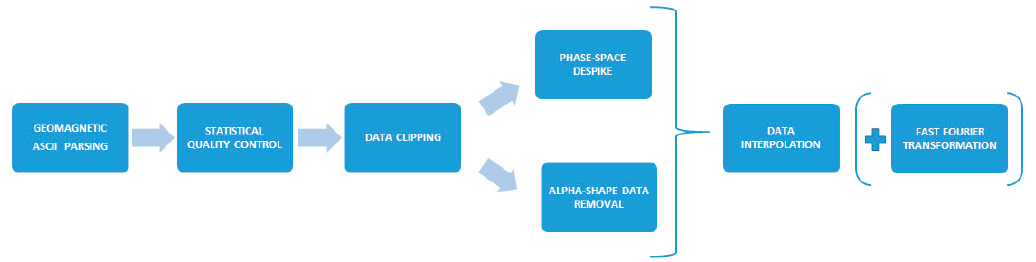
Figure 3. The IGEAN workflow for processing geomagnetic data. The first three steps (ASCII parsing, quality control, and data clipping) are standardized. The proceeding steps and their related parameters are case dependent.